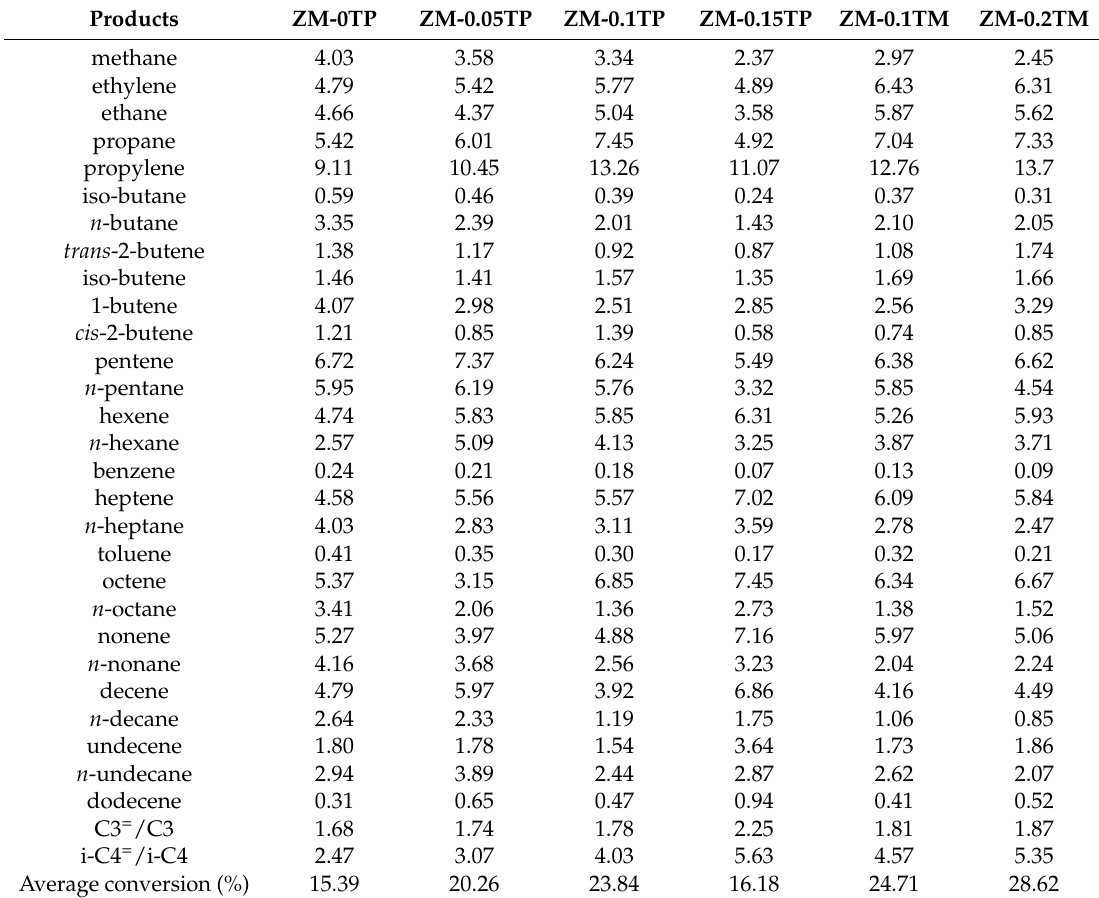
Table 3. Average conversion and mass selectivity of the n -dodecane cracking over the zeolite membranes.